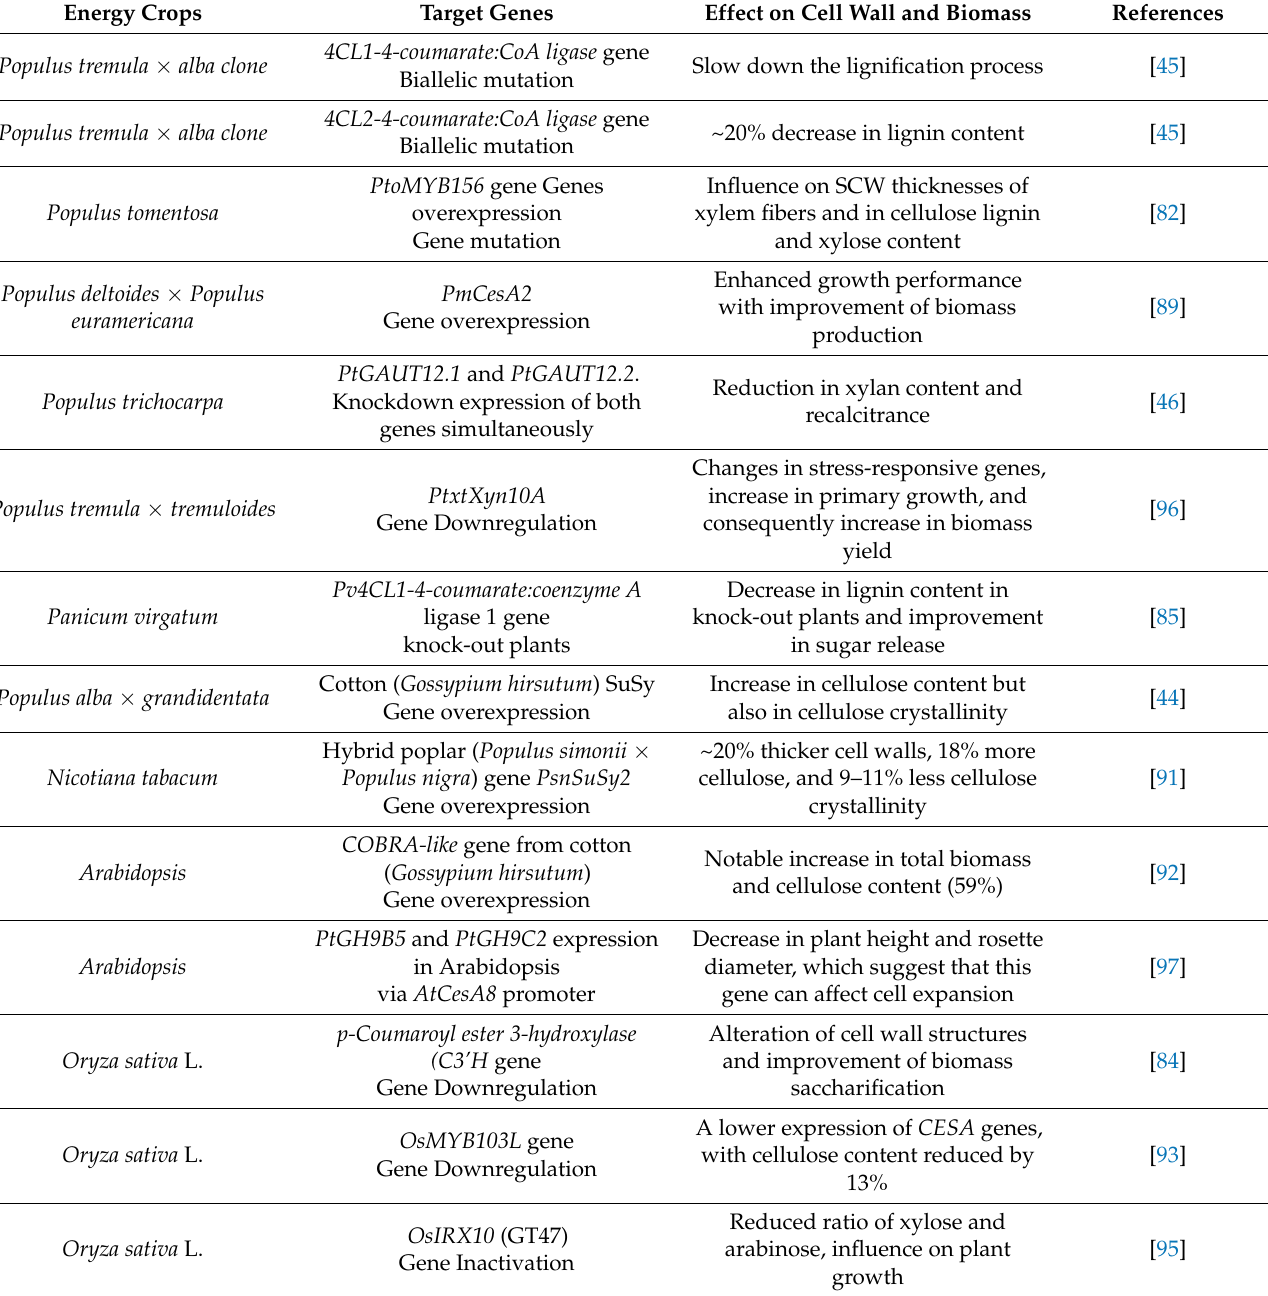
Table 6. Potential target genes for the improvement of energy